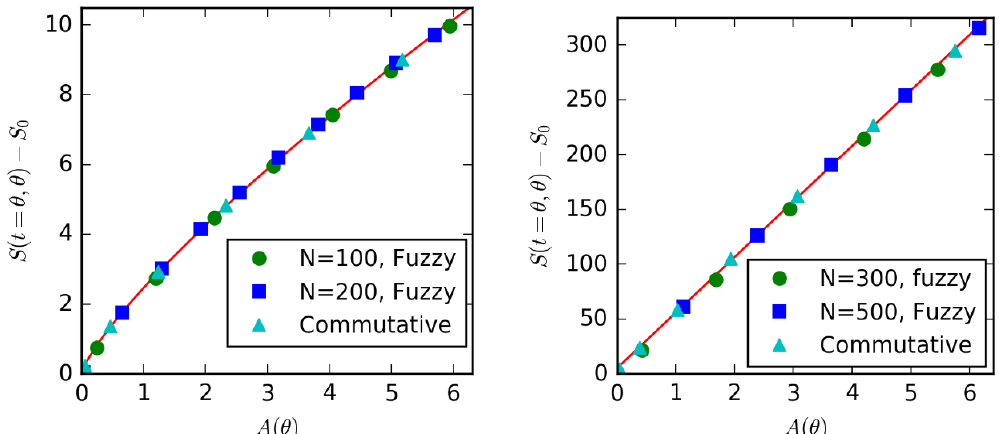
Figure 5 . Entanglement entropy at saturation time (with t = 0 contribution subtracted) as a function of area. The points correspond to the result on the fuzzy sphere at di(cid:11)erent N and the results on the commutative sphere, which are consistent with each other. The graph on the left is for (cid:22) = 5. The solid curve corresponds to a power law (cid:12)t, yielding a power of 0.79. The graph on the right is for (cid:22) = 30. There, the solid curve is from a linear (cid:12)t to the commutative results, with slope